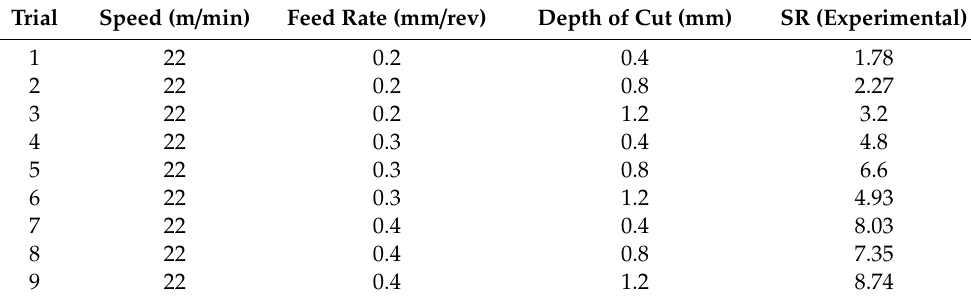
Table 3. Dry turning process experimental data